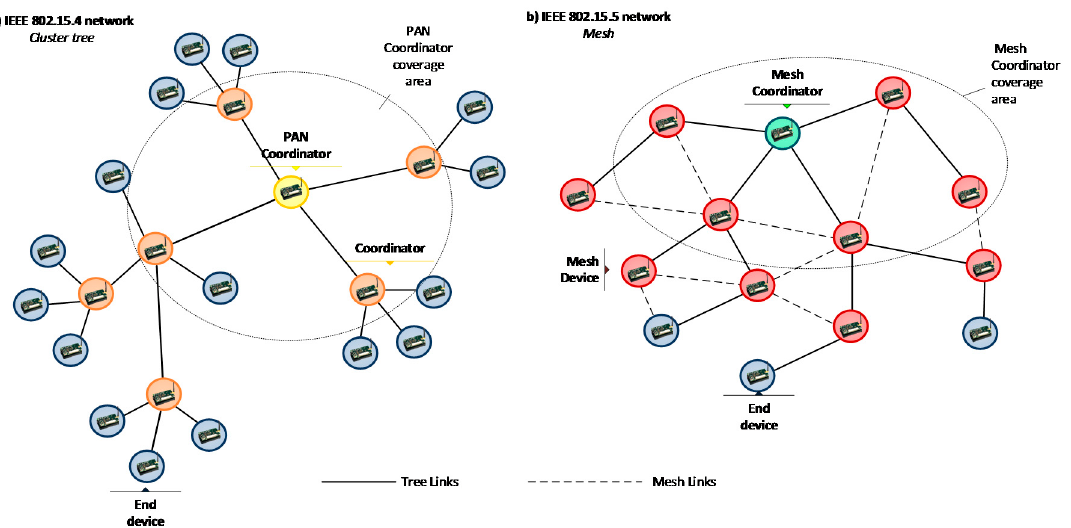
Figure 2. Topology examples. ( a ) IEEE 802.15.4 cluster tree; ( b ) IEEE 802.15.5 topology.